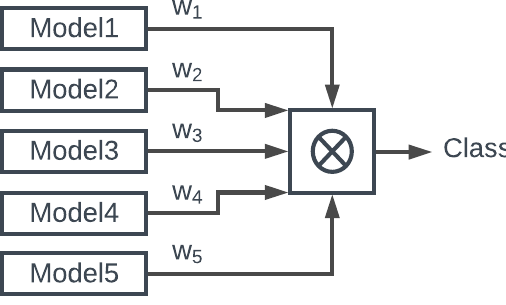
Figure 7. The Weighted Ensemble